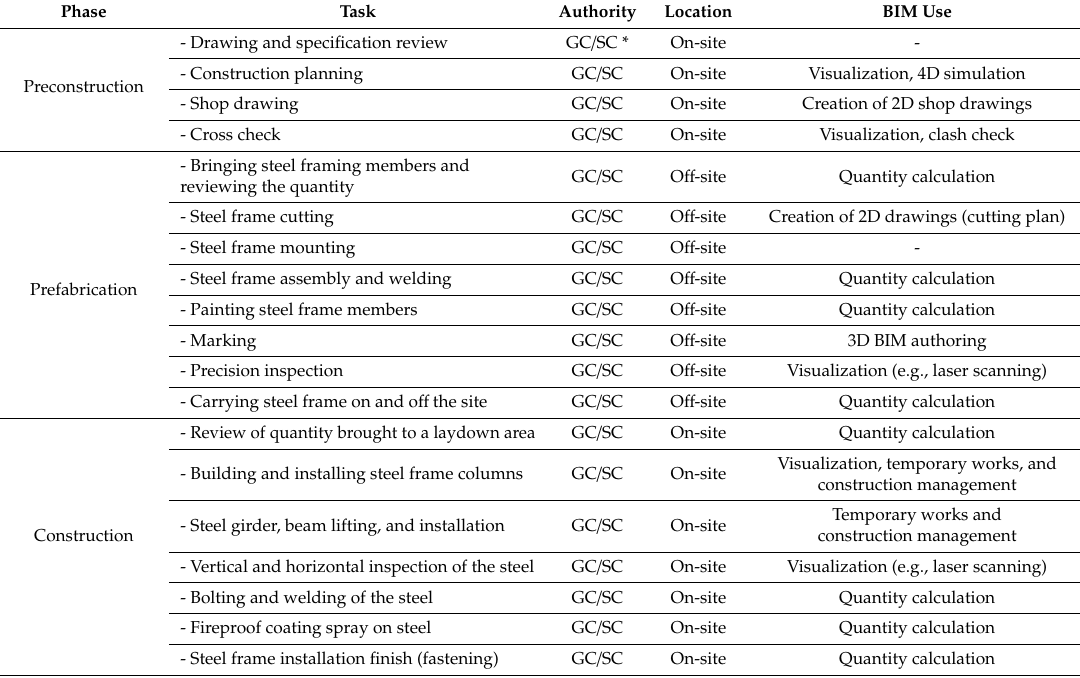
Table 4. Main tasks involved in steel frame construction and BIM use